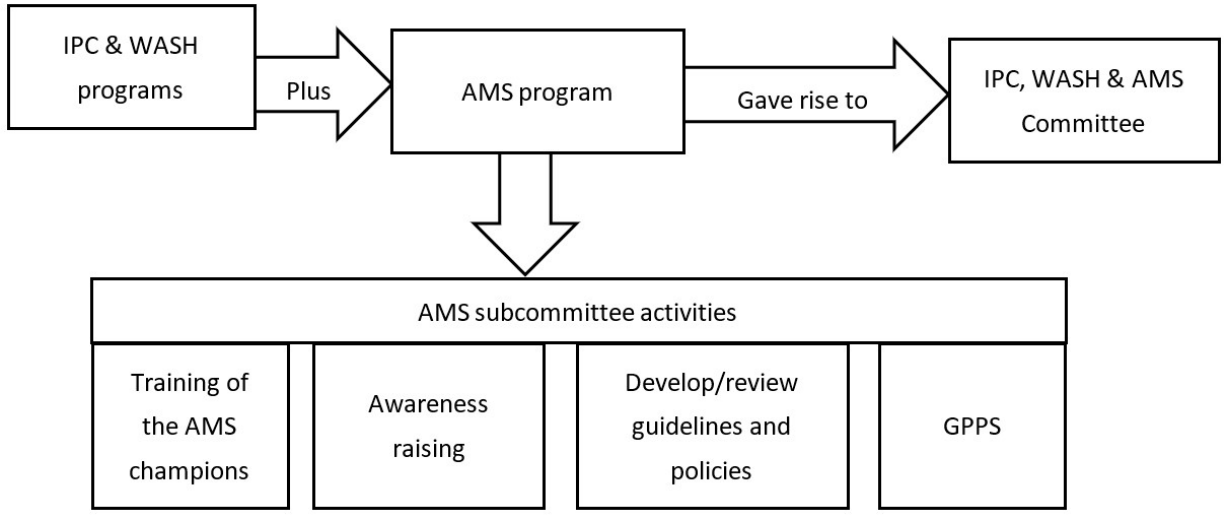
Figure 1. Flow diagram showing AMS subcommittee activities and related structures. AMS = Antimicrobial stewardship; GPPS = Global point prevalence survey; IPC = Infection Prevention and Control; WASH = Water Hygiene and Sanitation.